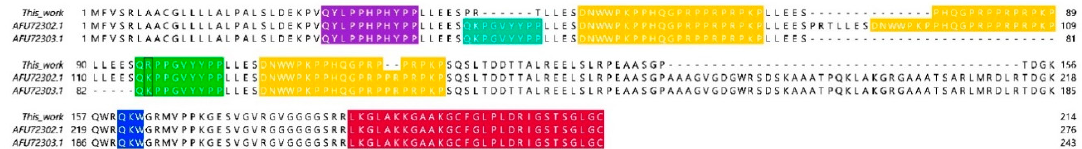
Figure 6. Amino acid sequences of C-type natriuretic precursors deduced from DNA sequences. Azemiopsin—yellow, Y-BPP—lilac, R-BPP and its Lys-analog—light green, putative shortened R-BPP analog—turquoise, putative tripeptide metalloproteinase inhibitor—blue, atrial natriuretic peptide—red.